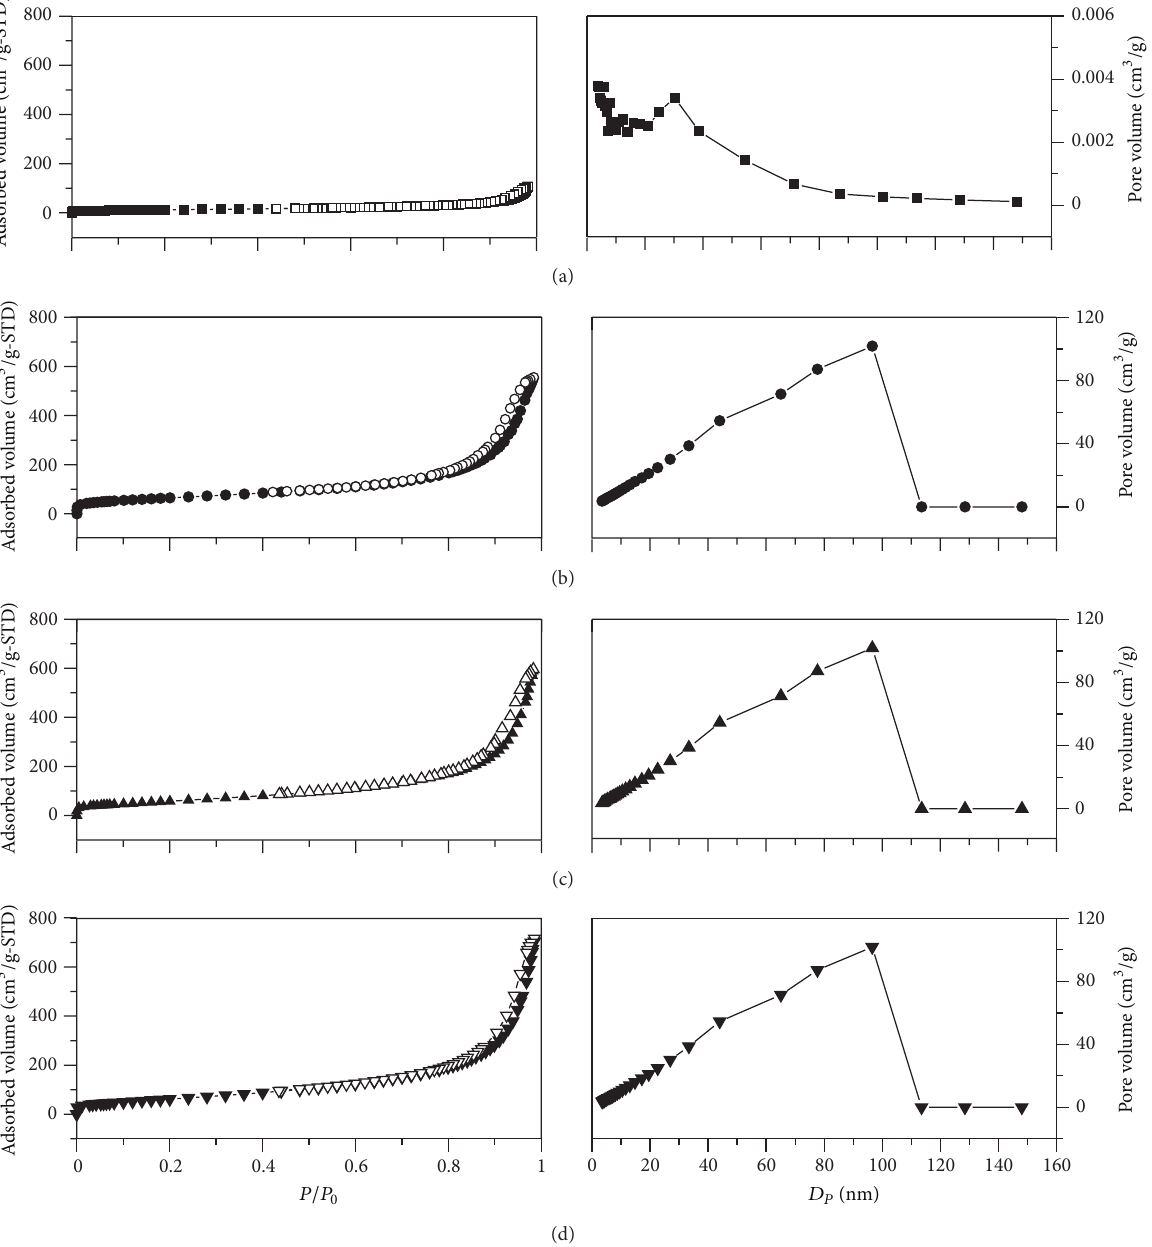
Figure 3: N 2 adsorption/desorption isotherms and the corresponding Barrett-Joyner-Halenda pore size distribution of the (a) nanosize TiO 2 , (b) TNT, (c) Cu-TNT, and (d)